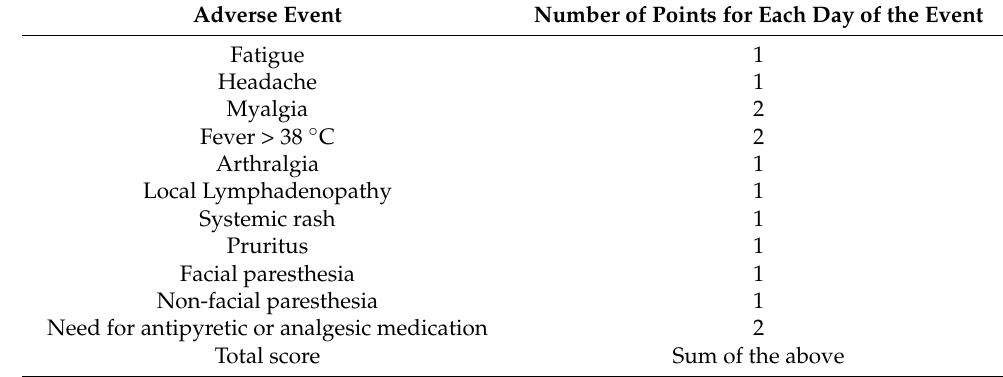
Table 1. Adverse events score system. Adverse Event Number of Points for Each Day of the Event Fatigue 1 Headache 1 Myalgia 2 Fever > 38 ◦ C 2 Arthralgia Systemic